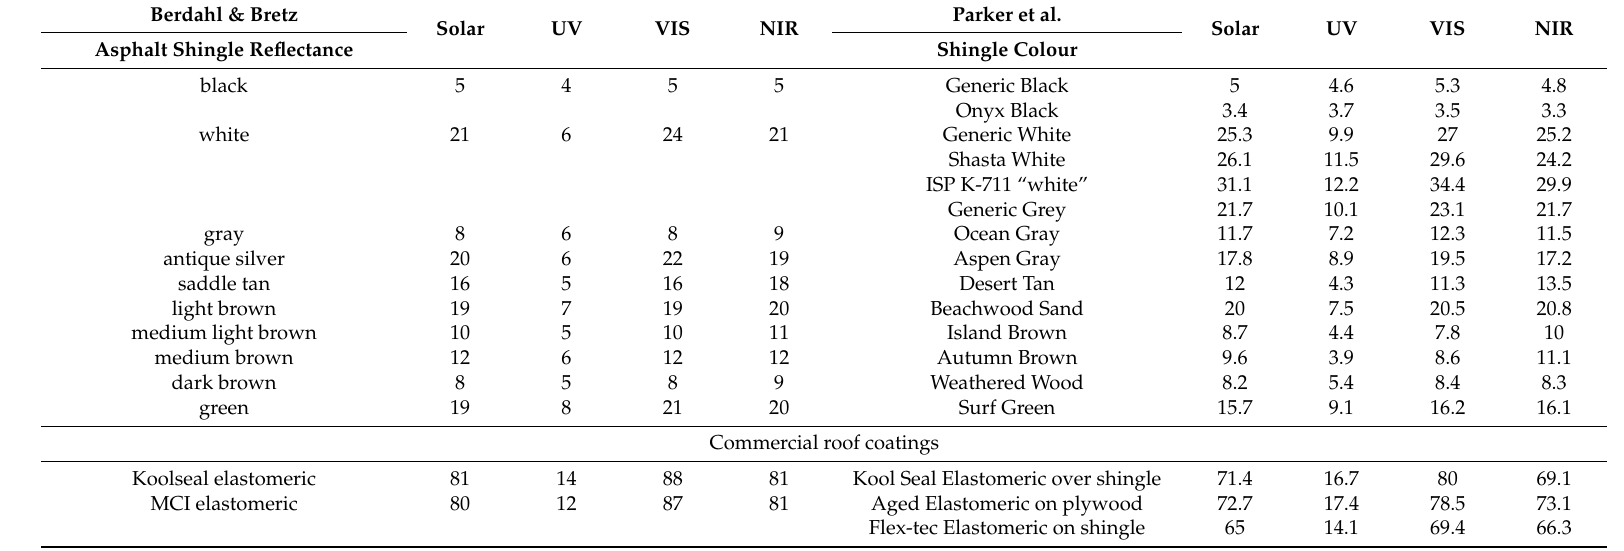
Table 5. Comparison of reflectance measurement as a percentage in different broadband wavebands, for similar commercial products by [22,33]. The divisions are reported by Parker et al. [33] as total solar reflectance (300 nm to 2500 nm), UV reflectance (300 nm to 400 nm), visible (VIS) reflectance (410 nm to 722 nm) and Near Infrared (NIR) reflectance (724 nm to 2500 nm). Divisions not reported by Berdahl and Bretz